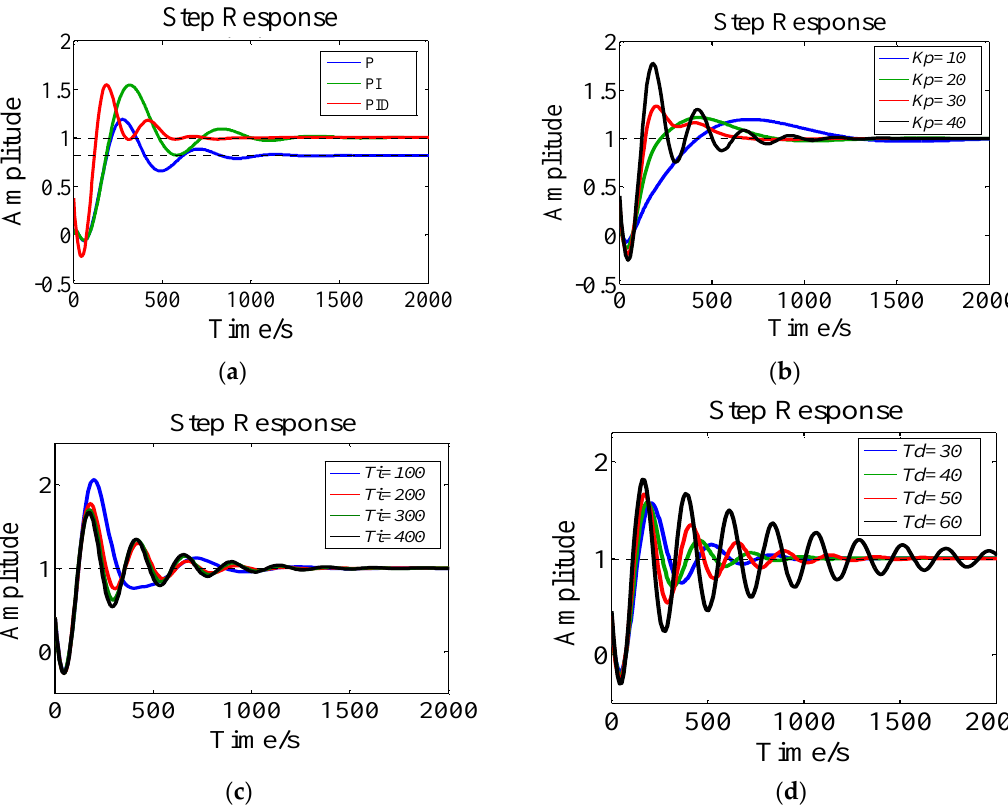
Figure 5. The curve of the system simulation result: ( a ) the simulation results of the P, PI, PID controller; ( b ) sweep results of Kp ; ( c ) sweep results of Ti ; ( d ) sweep results of Td .